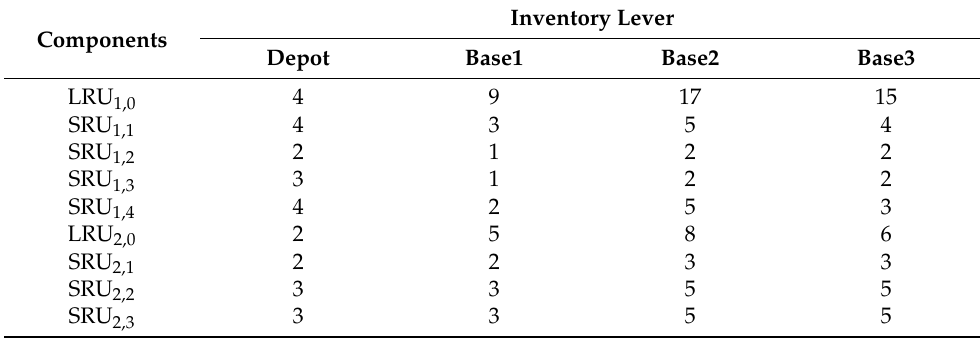
Table 2. Inventory optimization results.